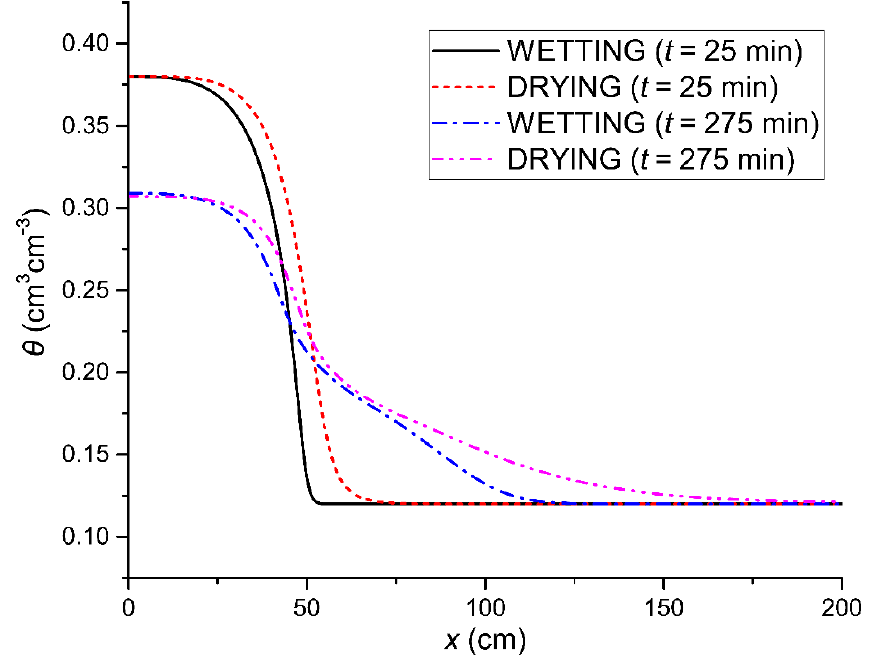
Figure 9. The horizontal soil water content redistribution (RED) profiles after infiltration with duration ( T = 25 min) for times, t = 25 min and t = 275 min, for the boundary wetting (WETTING) and the boundary drying (DRYING) θ –H curves when the initial water content ( θ o = 0.12 cm 3 cm − 3 ) lies on the respective boundary wetting and drying curves.